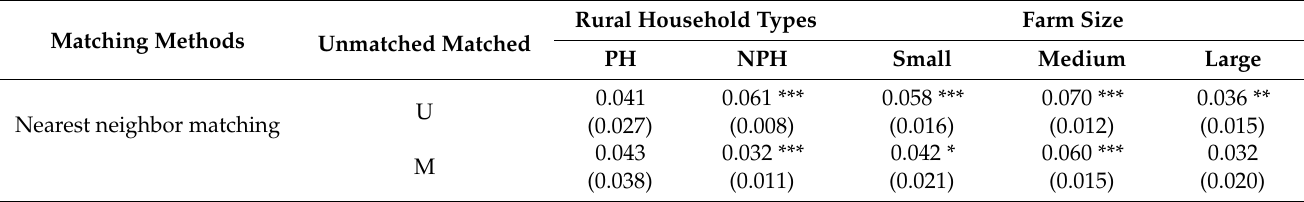
Table 6. Heterogeneity analysis